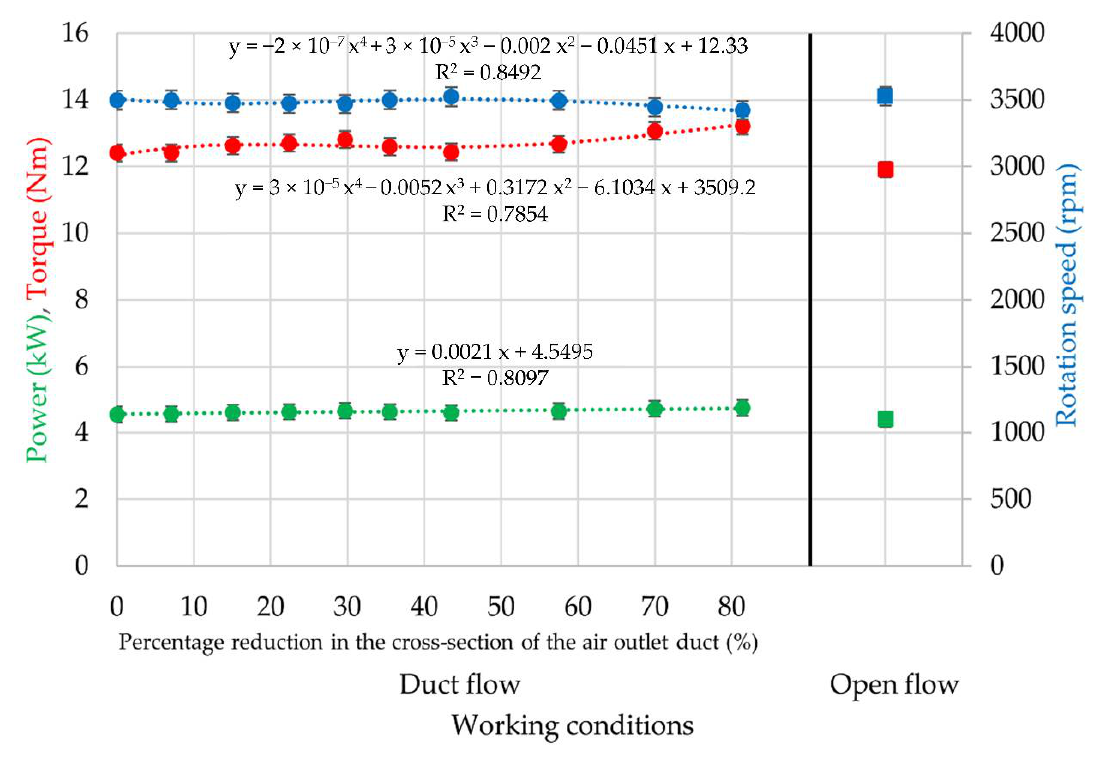
Figure 7. Characteristics of changes in the average power, torque, and speed during tests of fan W1 using Method A (duct flow) with variable damper closure and Method B (open flow).